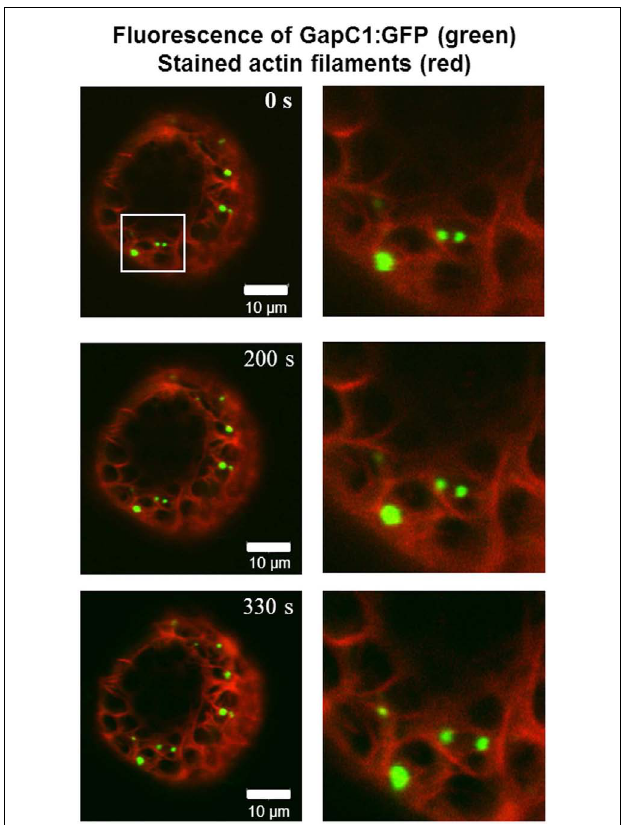
FIGURE 2 |Time-lapse images of GapC1:GFP aggregates with respect to the actin cytoskeleton. Time-lapse images of the GAPDH aggregates in relation to the actin cytoskeleton show GapC1:GFP aggregates moving along actin fibers (depicted with white frames). Images were taken after the indicated times. Actin filaments are stained with tdTomato:AtFim1 ABD2 (red).The GapC1:GFP foci are displayed in green. Scale bar: 10 µ m. The images were taken with the Confocal Laser Scanning Microscope LSM 510 META,